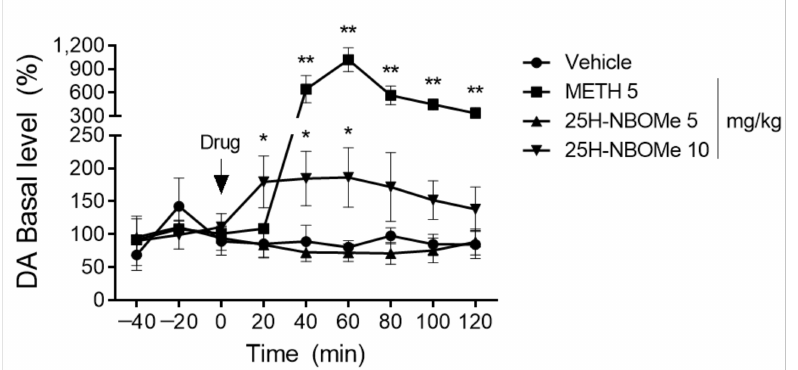
Figure 5. The dopamine (DA) levels in the striatum after i.p. administration of vehicle (saline), METH (5 mg/kg), and 25H-NBOMe (5 and 10 mg/kg). The black arrow indicates when the drug is administered. Data are expressed as mean ± SEM ( n = 3–4 each group). * p < 0.05, ** p < 0.01 vs. vehicle, determined by a two-way ANOVA followed by Dunnett’s post-hoc